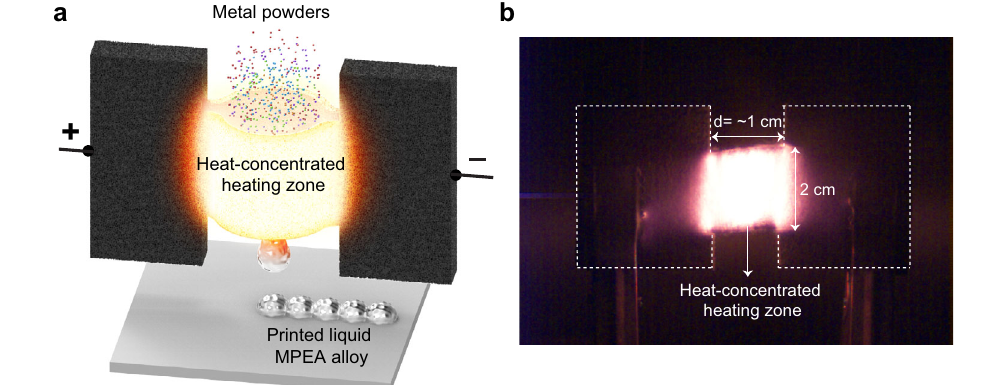
continuously into the heat-concentrated zone of which the temperature can be tuned to as high as 3000K with a uniform temperature distribution. The metal powders are rapidly heated, melted on the order of milliseconds, and alloyed into uniform MPEAs. b Photograph of the ultrahigh-temperature, heat-concentrated platform for multi-elemental metal melt